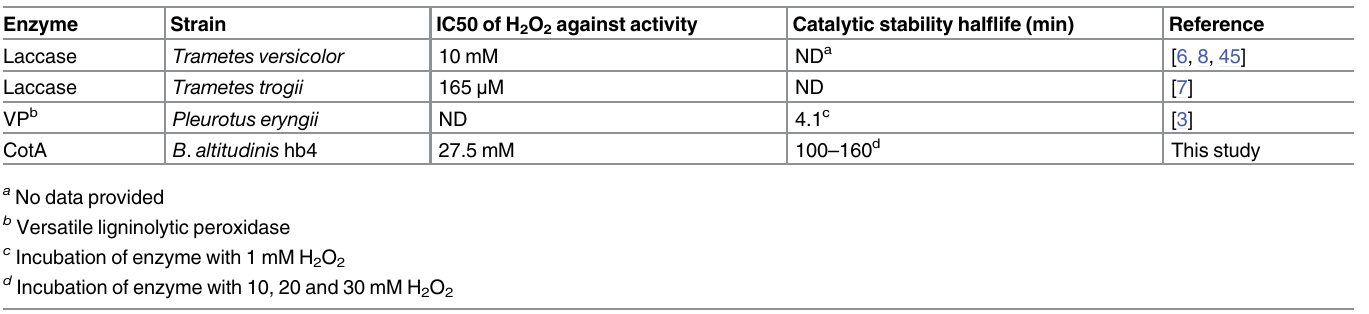
Table 5. Effects of H 2 O 2 on activity of laccase and peroxidase toward